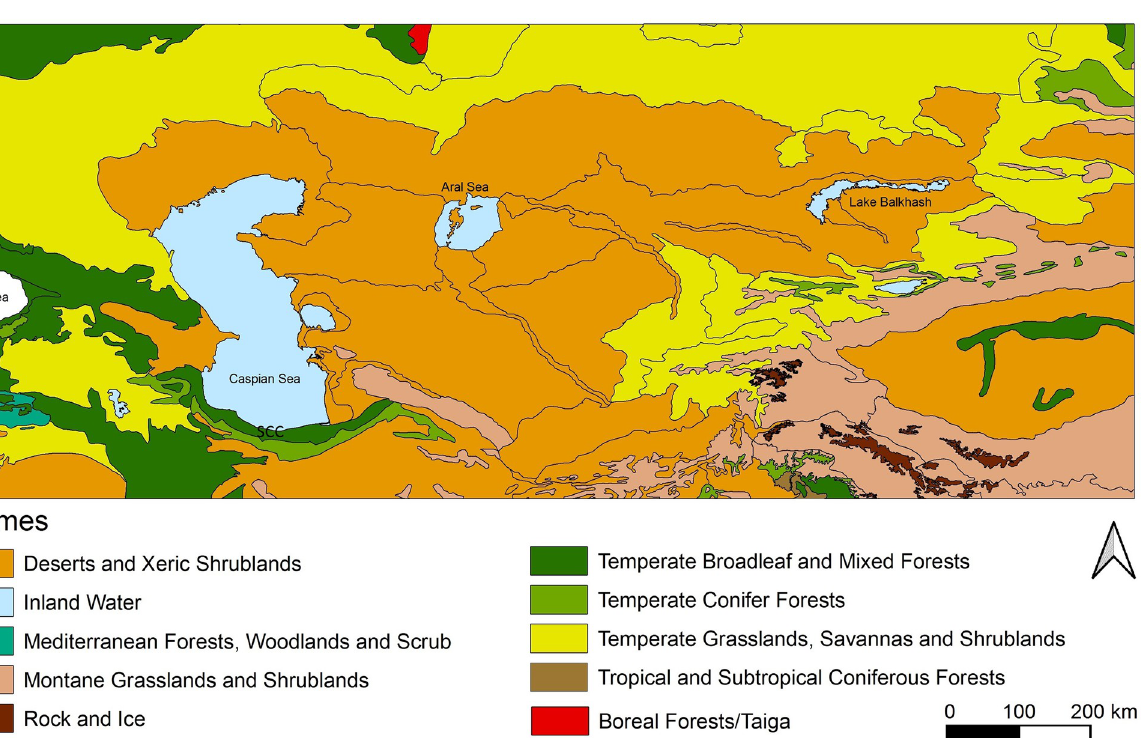
PLOS ONE | https://doi.org/10.1371/journal.pone.0281978 February 23,